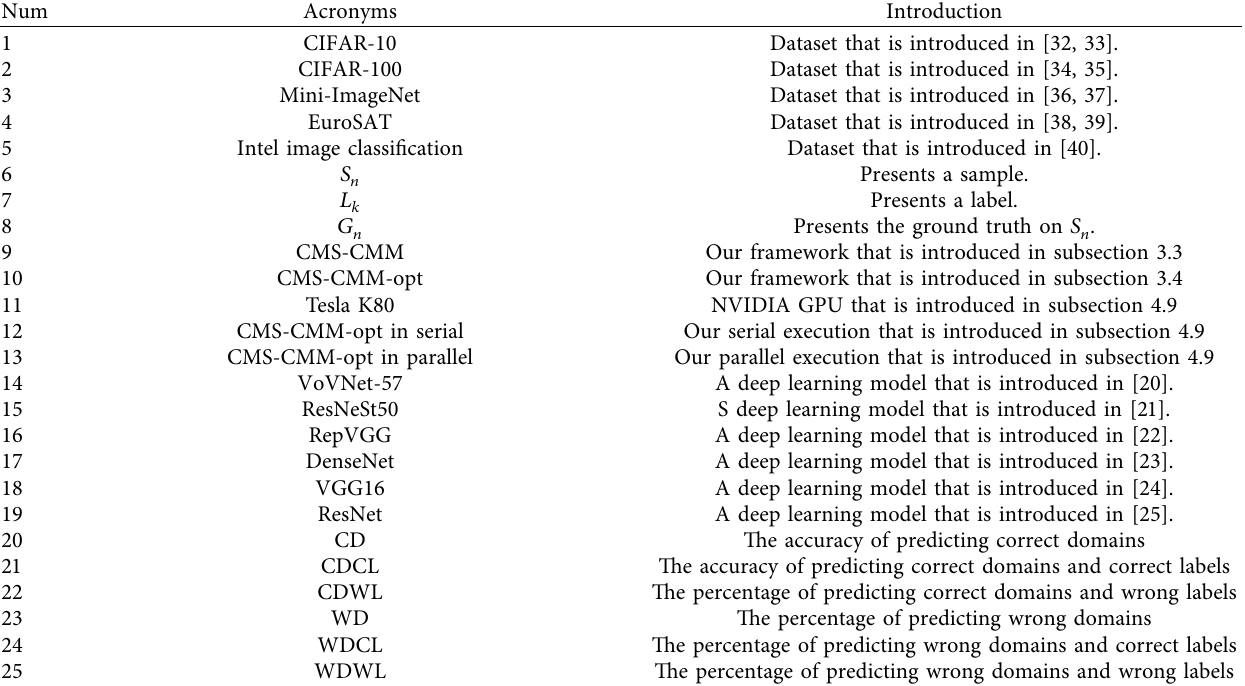
Table 9: Introduction of the employed